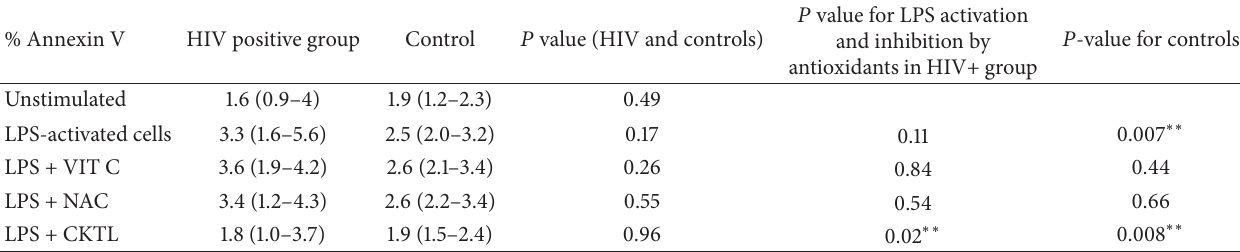
Table 3: The % annexin V+/7-AAD − staining of the HIV positive and the control groups.